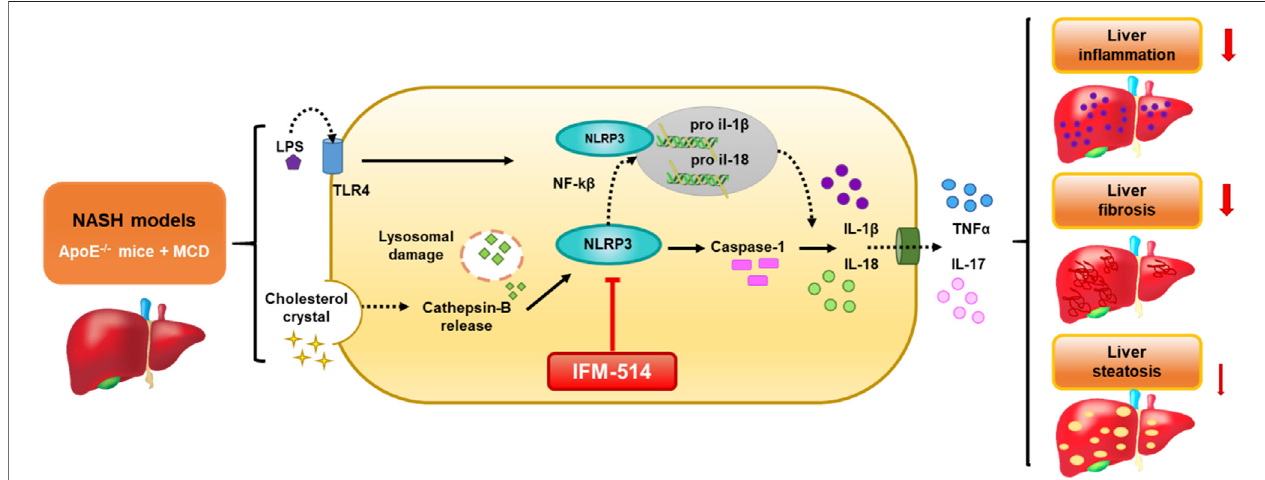
GRAPHICAL ABSTRACT | Schematic representation of the IFM-514 treatment effect in experimental murine NASH. The activation of NLRP3 in fl ammasome in response to NASH models is due to the gut-derived PAMPs, such as LPS, and cholesterol crystals. LPS activates nuclear factor kappa B (Nf-kB) via triggering of the TLR4 receptor and consequently promotes the expression of pro-IL-1 β and pro-IL-18. Cholesterol crystals produce lysosomal damage with cathepsin-B release that also activates NLRP3, followed by caspase-1 activation that allows the release of IL-1 β and IL-18 into the extracellular space and increasing TNF- α and IL-17. All these cytokines promote an increase in liver in fl ammation, fi brosis and steatosis. In our study, IFM-514, an NRLP3 antagonist, could protect prior to the pathogenesis produced by NASH murine model, with mild effect in liver steatosis.